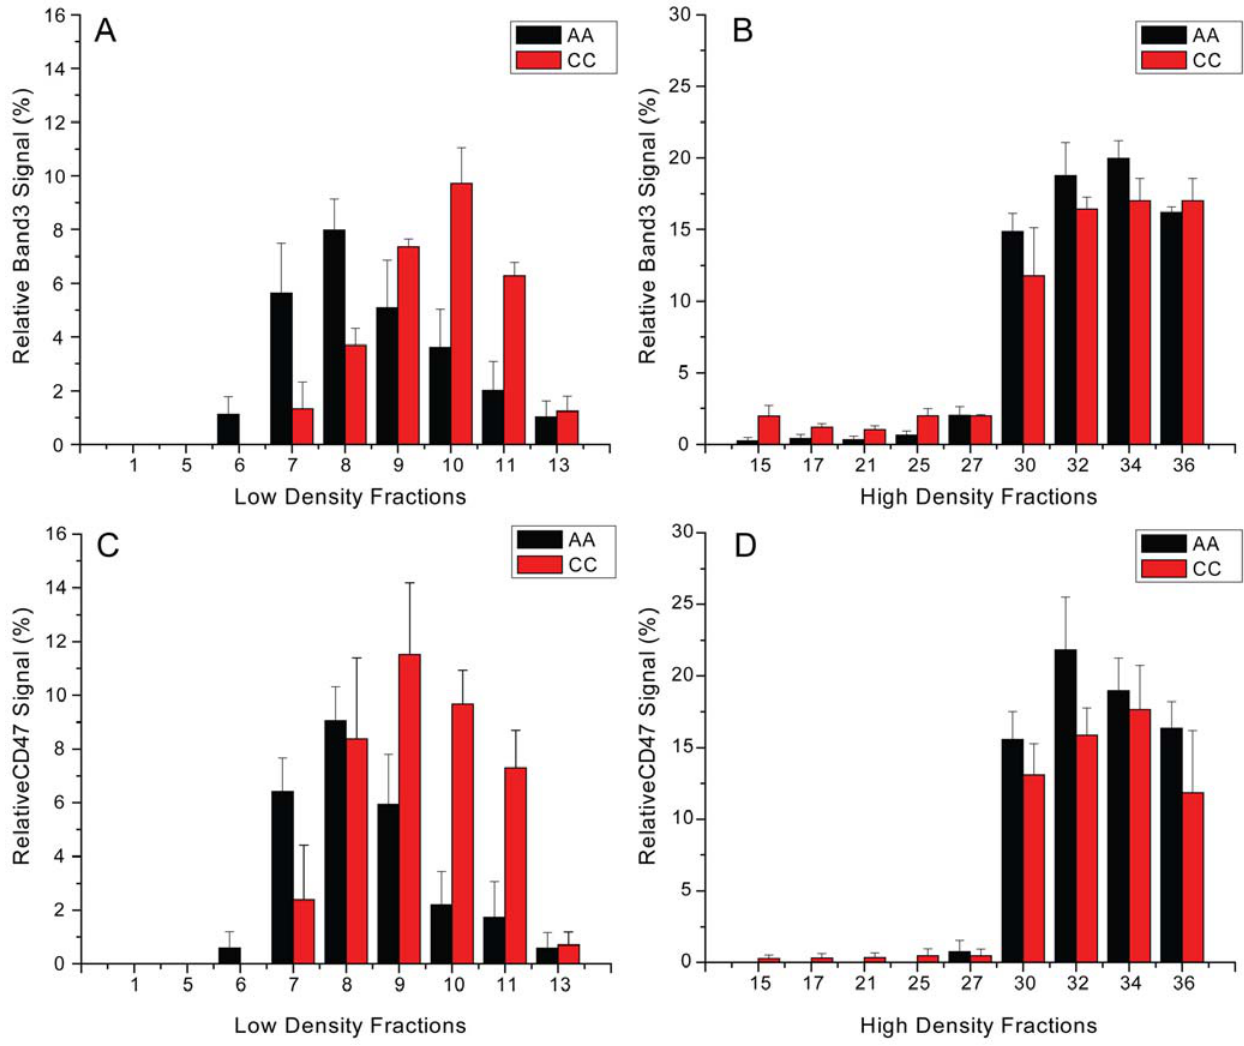
Figure 4. Distributions of relative band 3 and CD47 signals from dot blot analyses. For each protein, the sum of signals from all fractions was set as 100%. Band 3 (A, B) and CD47 (C, D) signals showed similar distributions in the high density fractions of AA and CC samples. However, differences in band 3 and CD47 signal distributions were observed in the low density fractions of AA and CC samples. Higher density signals for both proteins in CC samples appeared in fractions 9–11, which correspond to visible